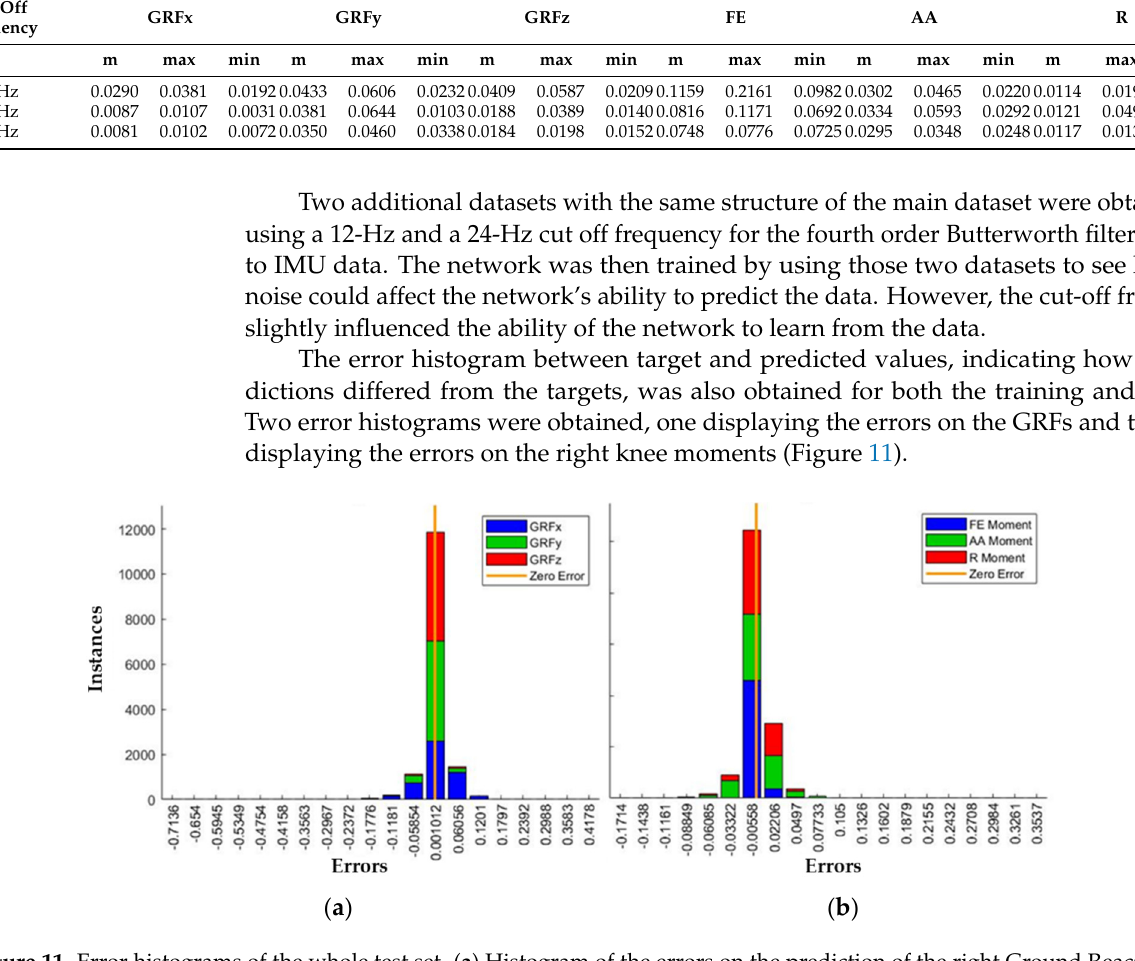
Figure 11. Error histograms of the whole test set. ( a ) Histogram of the errors on the prediction of the right Ground Reaction Forces; ( b ) Histogram of the errors on the prediction of the moments at the right knee joint.